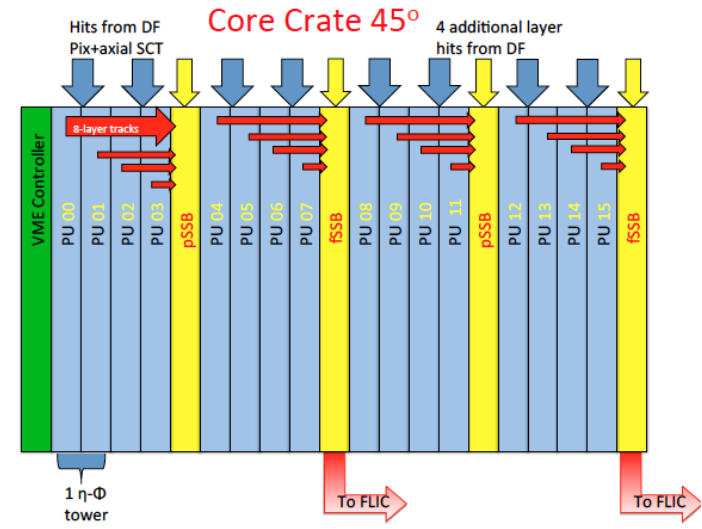
Figure 5. Layout of an FTK core crate and the interboard and intercrate data